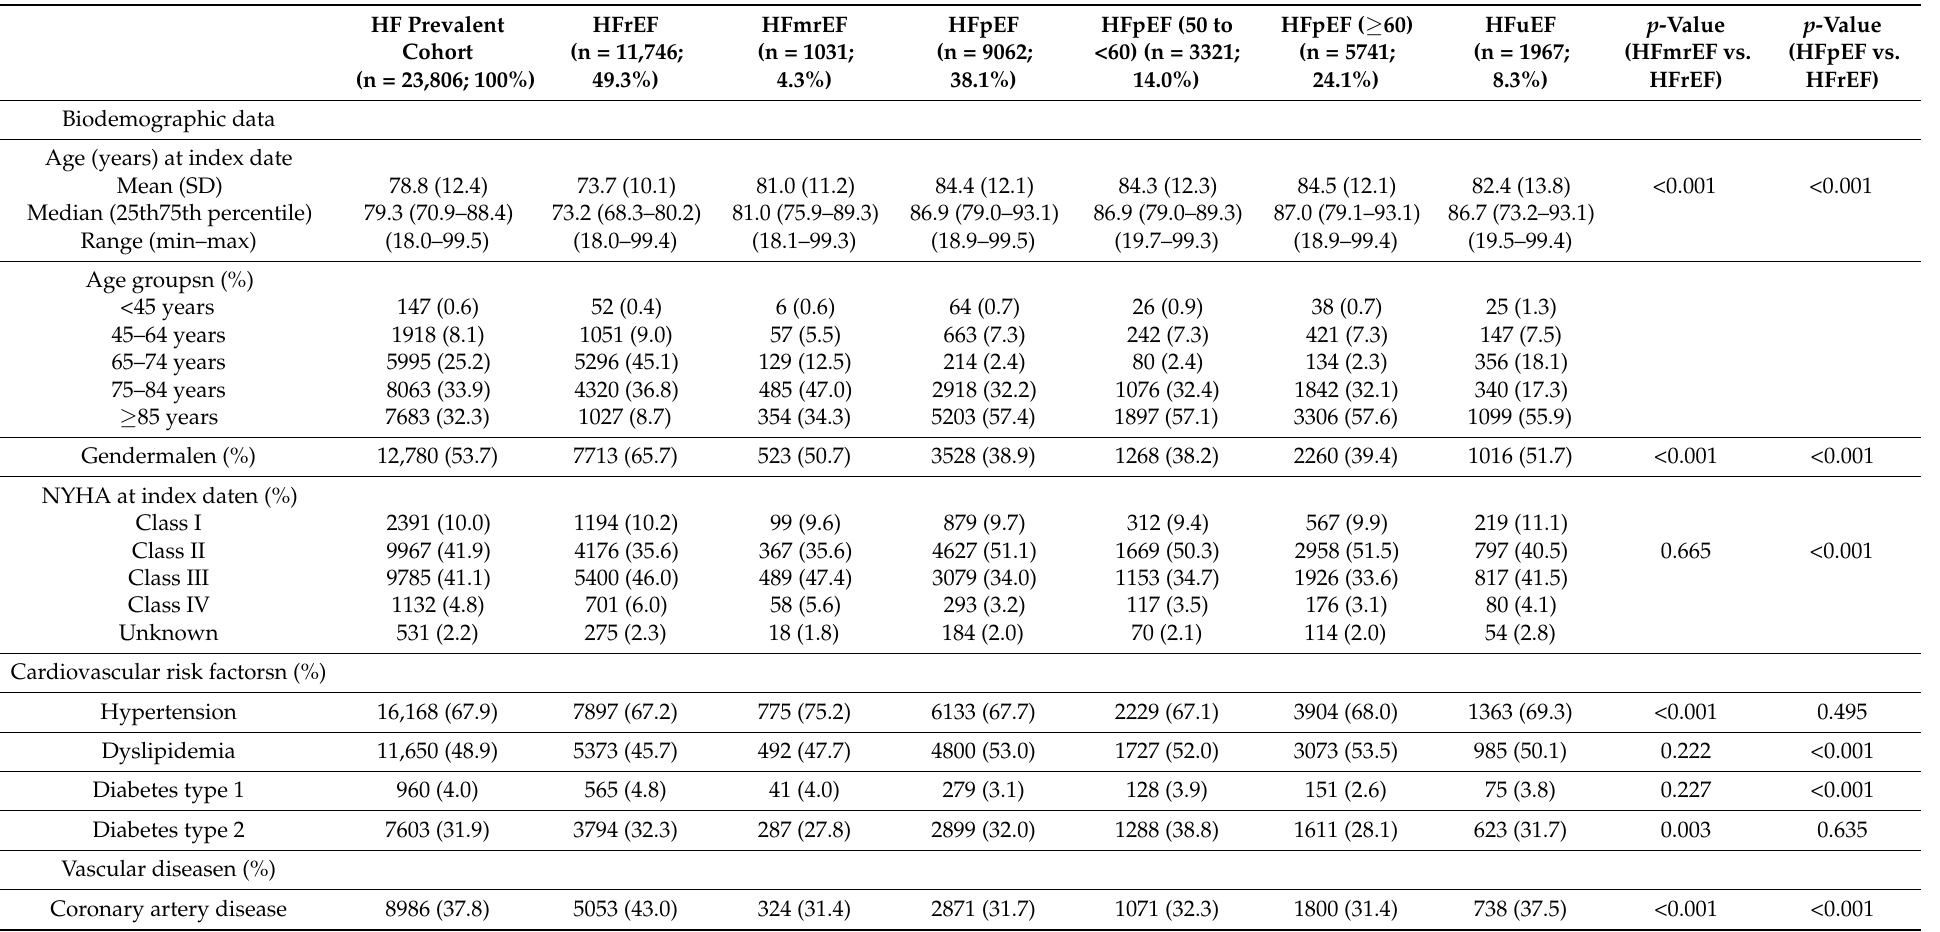
Table 2. Baseline characteristics and treatments in the prevalent heart failure cohort (index date 1 January